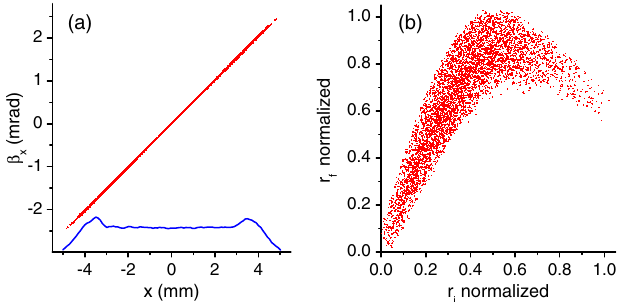
FIG. 3. (a) The transverse phase space x (cid:1) (cid:3) when the UV stretcher was off and the laser pulse short at the cathode. The density profile along x axis is also shown (blue line). (b) The correlation between the initial transverse positions r at the cathode and the final positions r i